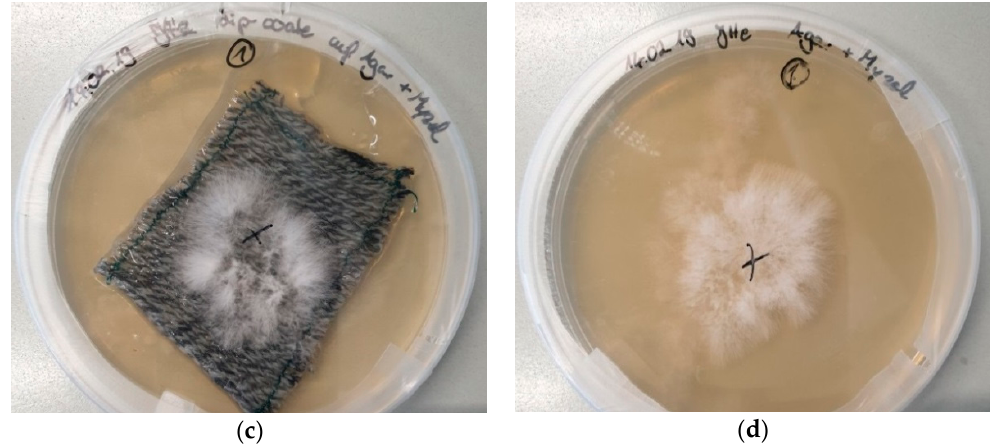
Figure 2. Pleurotus ostreatus mycelium grown on different substrates, 4 days after inoculation: ( a ) acrylic knitted fabric on agar plate; ( b ) acrylic knitted fabric dip-coated with agar; ( c ) acrylic knitted fabric dip-coated with agar on agar plate; ( d ) agar plate.